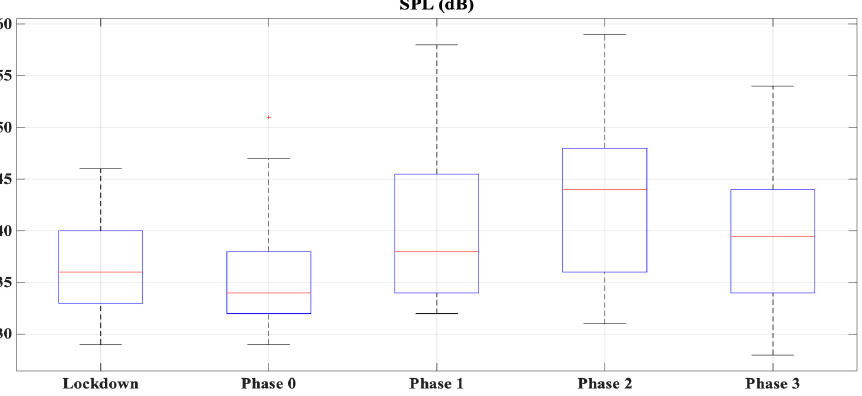
Figure 4. Boxplot of the Sound Pressure Level (SPL) during de-escalation in Ronda Marrubial C ó rdoba.